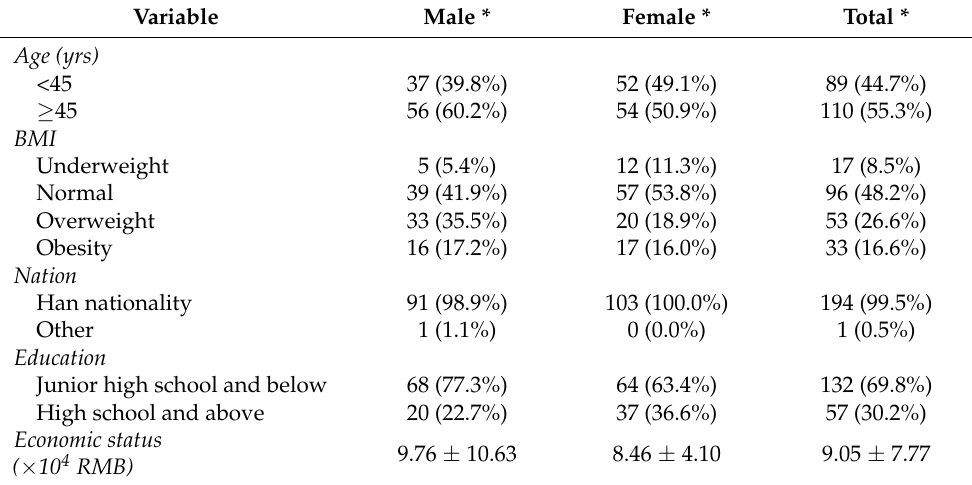
Table 2. Basic information of study subjects.